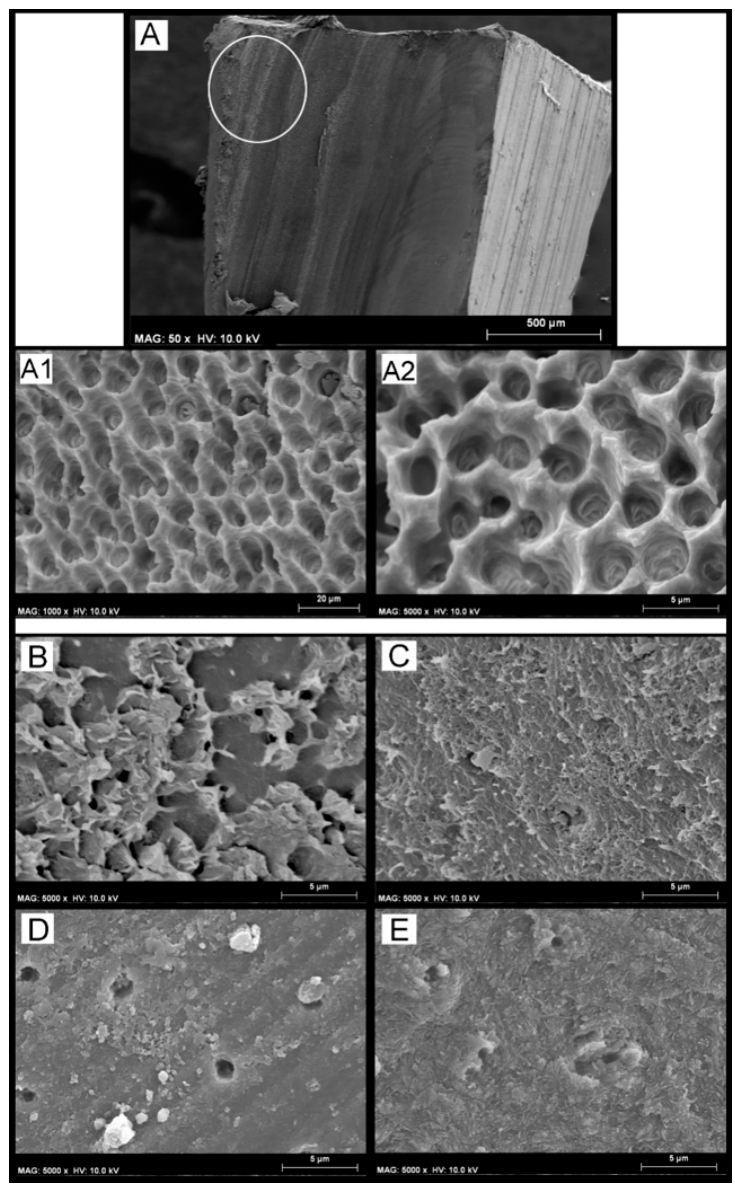
Figure 3. SEM Fractographic analysis after load cycling and aging in artificial saliva. ( A ) SEM fractography of a specimen created with SCU applied in ER mode and restored with RC showing a characteristic failure in adhesive mode. Note that the white circle indicates no physical difference in the material; it was added to show the reader that images ( A1 ) and ( A2 ) were obtained by higher magnification in that zone. Indeed, in ( A1) and ( A2) it is possible to see severe collagen degradation without the presence of any resin residual. ( B ) SEM fractography of a specimen created with SCU applied in SE mode where it is possible to see a failure between composite and adhesive, probably due to degradation induced by excessive water sorption upon mechanical stress and prolonged AS storage. However, it was also possible to see, in those specimens that failed in mixed mode, signs of degradation of the collagen fibrils underneath the hybrid/interdiffusion layer ( C ). ( D ) SEM fractography of a specimen created with SCU applied in ER mode and restored with ACTIVA showing that the failure occurred underneath the hybrid layer, but the exposed dentine is well mineralized with no sign of exposed demineralized collagen fibrils. Note also the presence of mineral debrides that are a possible result of the bioactivity of ACTIVA, which released ions and diffused through the resin-bonded dentine. ( E ) SEM fractography of a specimen created with FTB applied in SE mode and restored with RMGIC. The specimens of this group failed mainly in cohesive and mixed